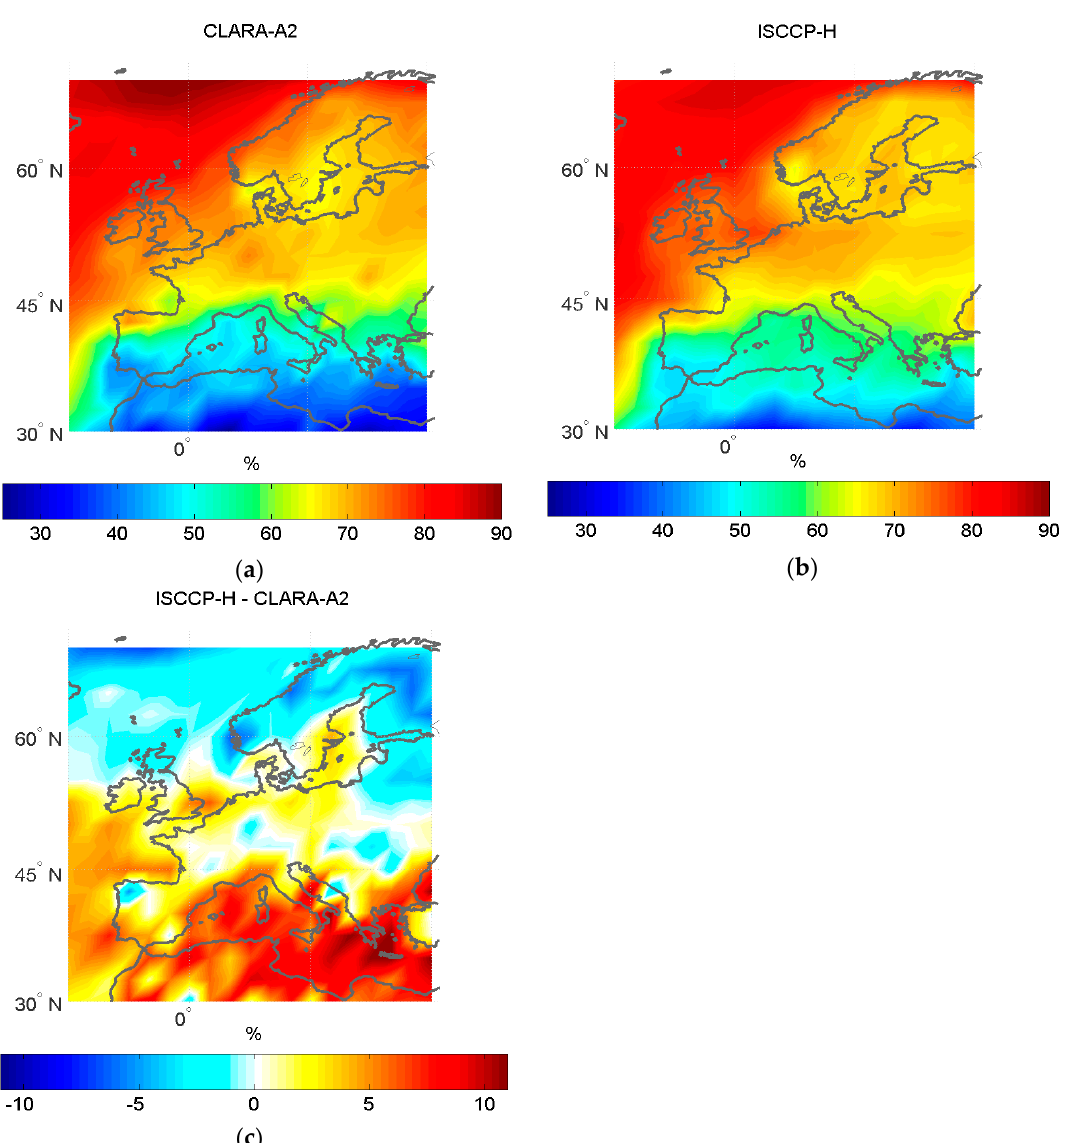
Figure 2. Average TCC for the 29-year period 1984-2012 over Europe based on ( a ) CLARA-A2 and ( b ) ISCCP-H, and ( c ) difference (in absolute terms) between ISCCP-H and CLARA-A2